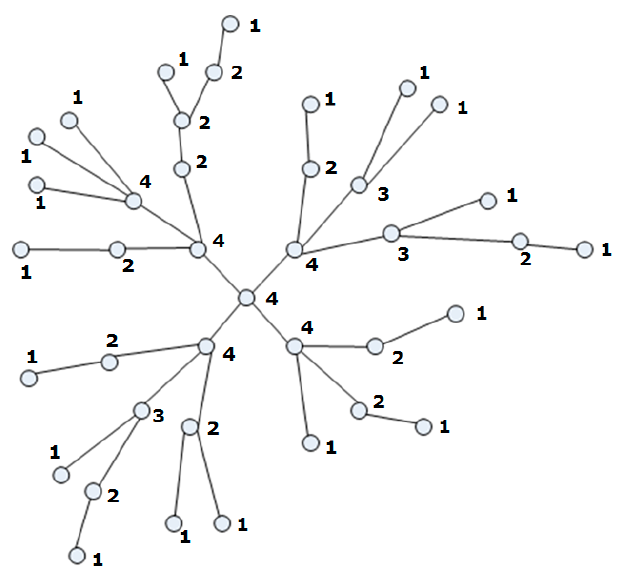
Figure 1. Step 1. Network with different weight